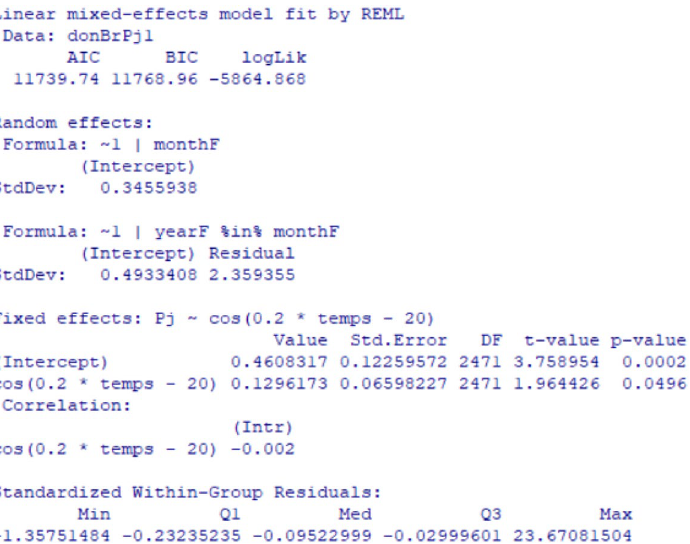
Figure 10. Summary of the model (3).